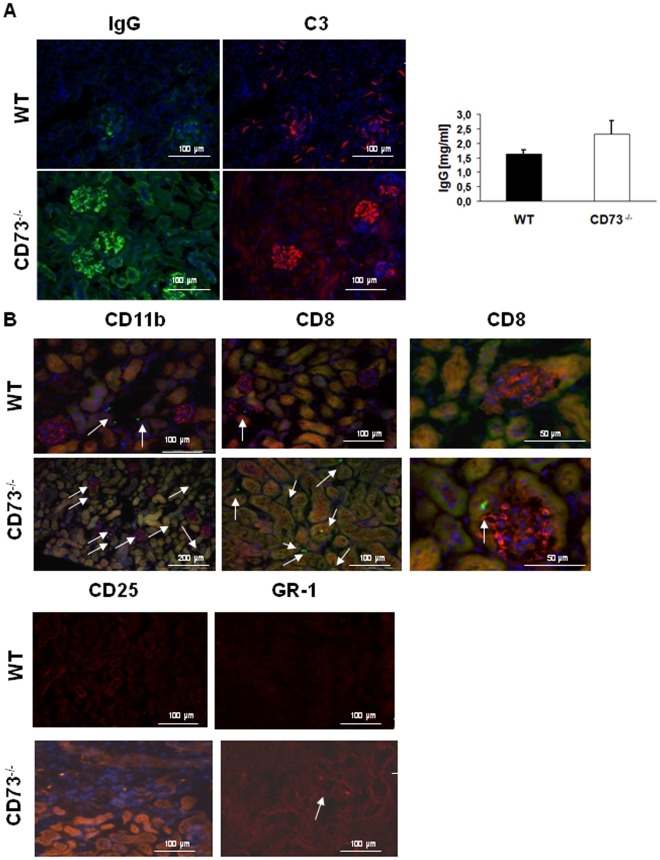
Collagen deposition in the renal cortex, peritubular and surrounding the glomeruli in CD73−/−mice.(A) Representative images of fibrillar collagen deposition shown by Sirius Red staining (in CD73−/−as compared to WT controlc mice, ×200 magnification). (B) Image analysis demonstrates that CD73−/−mice exhibit increased levels of fibrillary collagen deposition within the cortex compared with WT controls (significance as indicated, p<0.002 CD73−/− vs WT mice, Sirius red staining, 3–5 images per animal, n = 7 animals/group, Student t-test).